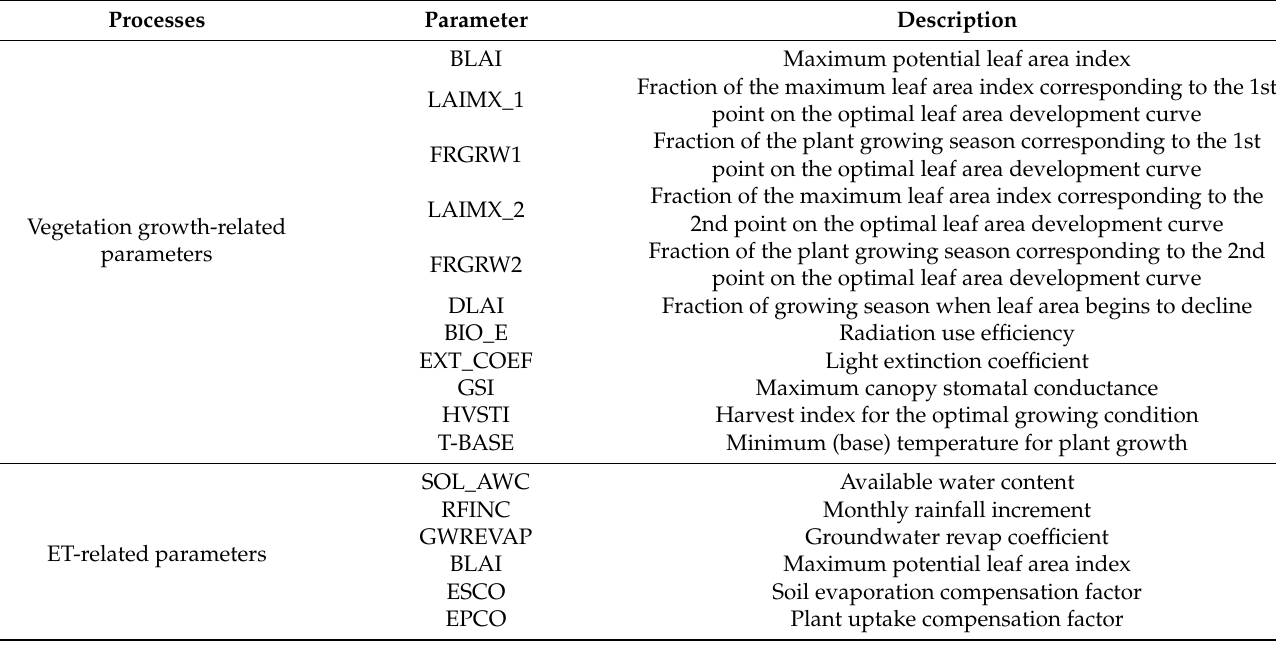
Table 2. Vegetation growth and ET ‐ related parameters in SWAT.